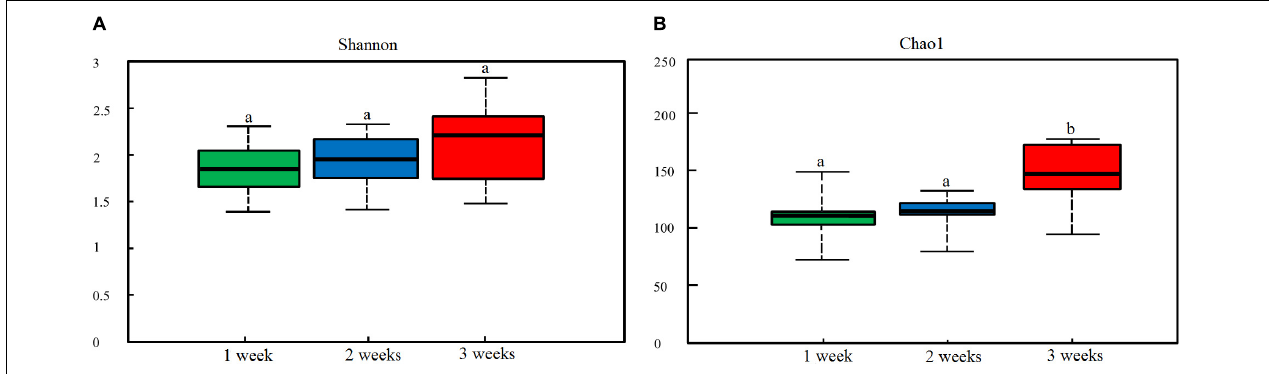
FIGURE 1 | Dynamic changes in gut microbial alpha diversity of PEDV-infected piglets determined by (A) Shannon index and (B) Chao1 index. Different letters above the bars denote a significant difference in alpha diversity index among the groups tested by paired sample Wilcoxon signed-rank test and adjusted for false discovery rate (FDR, p <